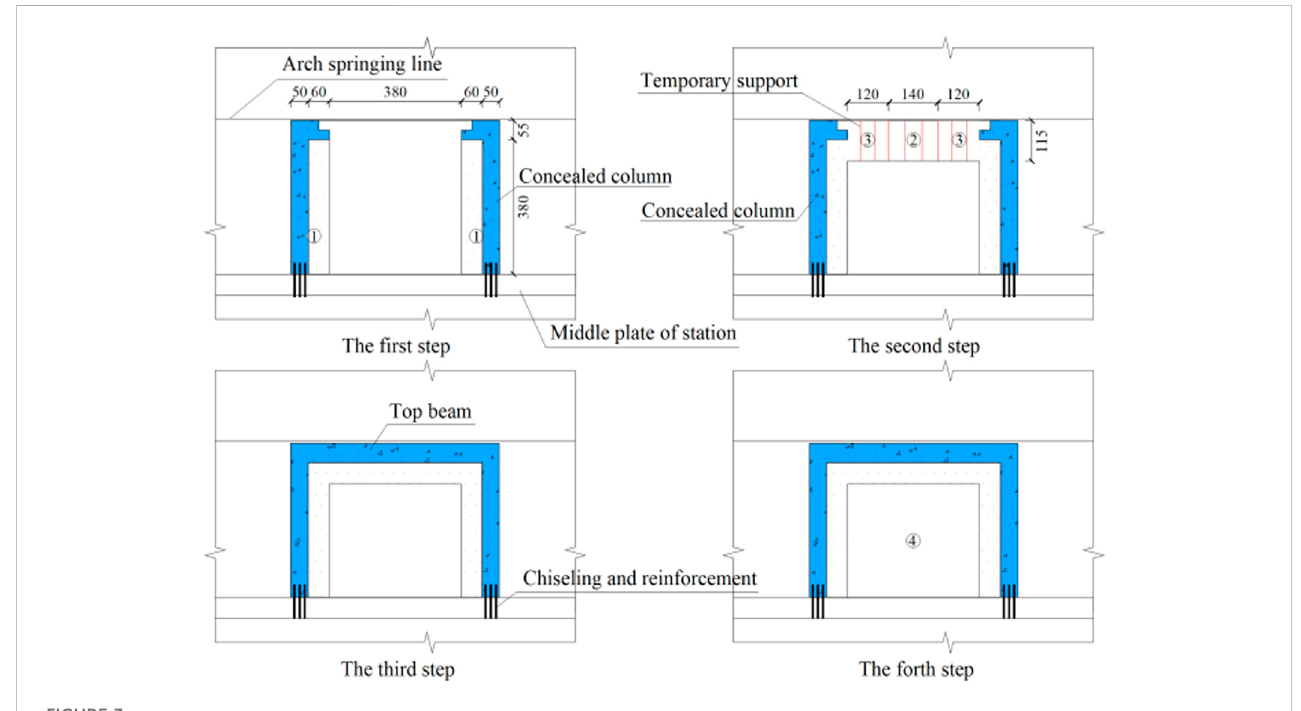
FIGURE 3 The processes of opening construction (cm).